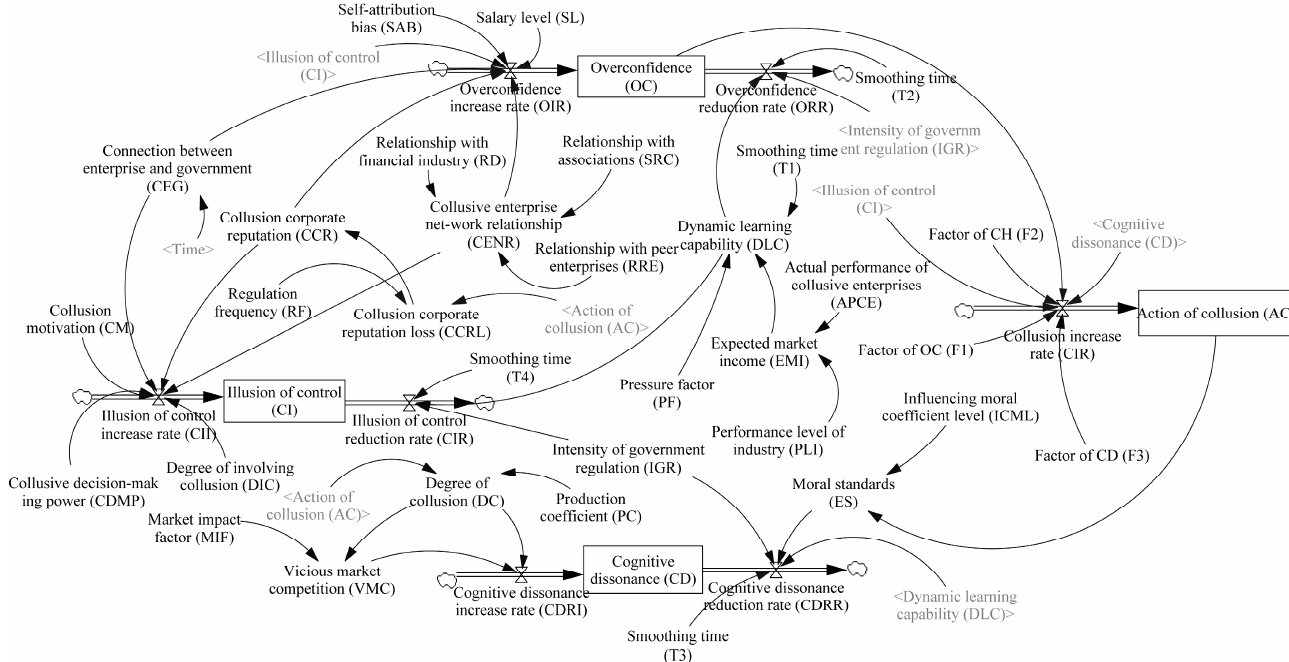
Figure 2. A to-collude decision-making model.